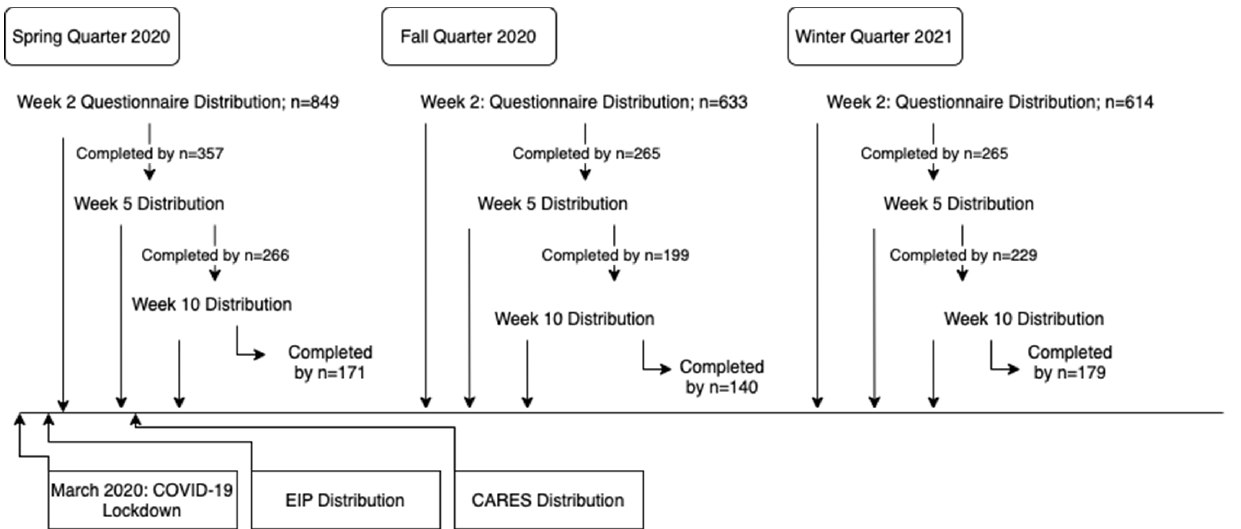
Figure 1. Study Timeline. The EIP Distribution and CARES Distribution refer to the Economic Impact Payment (EIP) and funds from the Coronavirus Aid, Relief, and Economic Security (CARES) Act, respectively.